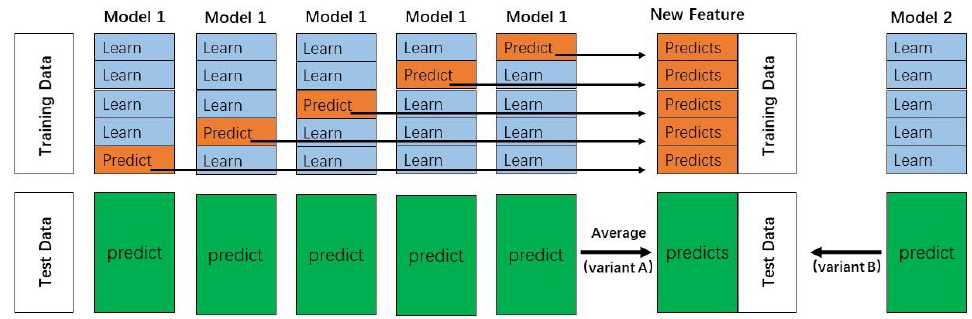
Figure 1. Detailed steps for stacking integrated five-fold